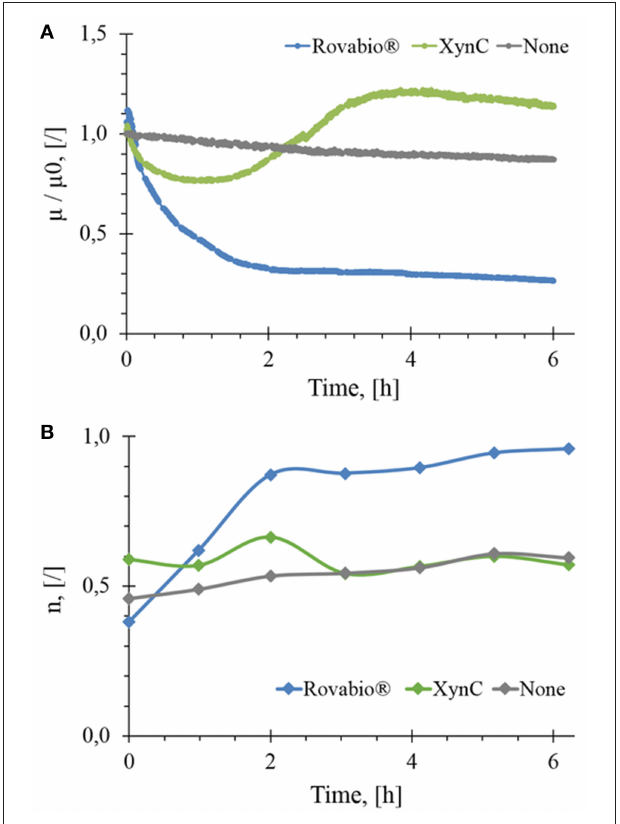
FIGURE 2 | Normalized in-situ viscosity (A) and flow behavior index (B) as a function of the hydrolysis time of wheat bran suspension by Rovabio ® (A) , pure xylanase C (XynC) and without enzyme (None). Operationg conditions: destarched wheat bran suspended in a potassium phosphate 0,1M at 41 ◦ C, pH 4.0, initial concentration 74 g/L, Robavio Advance and xylanase C 400 U xylanase visco